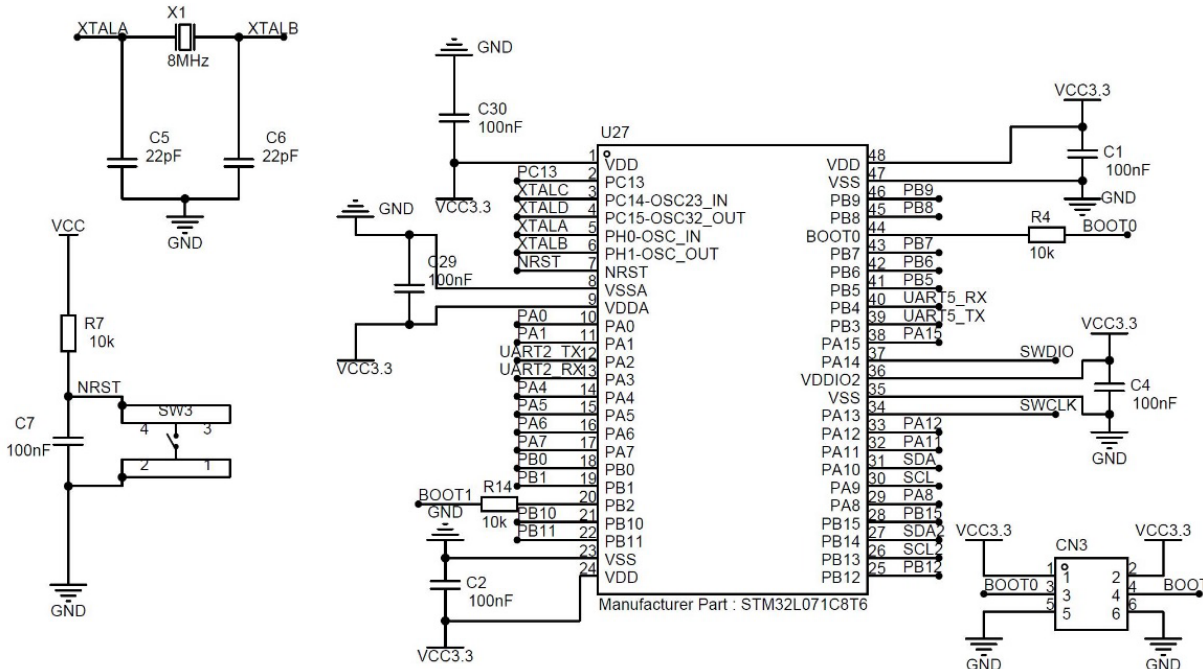
Figure 9. Core circuit of attitude control system.